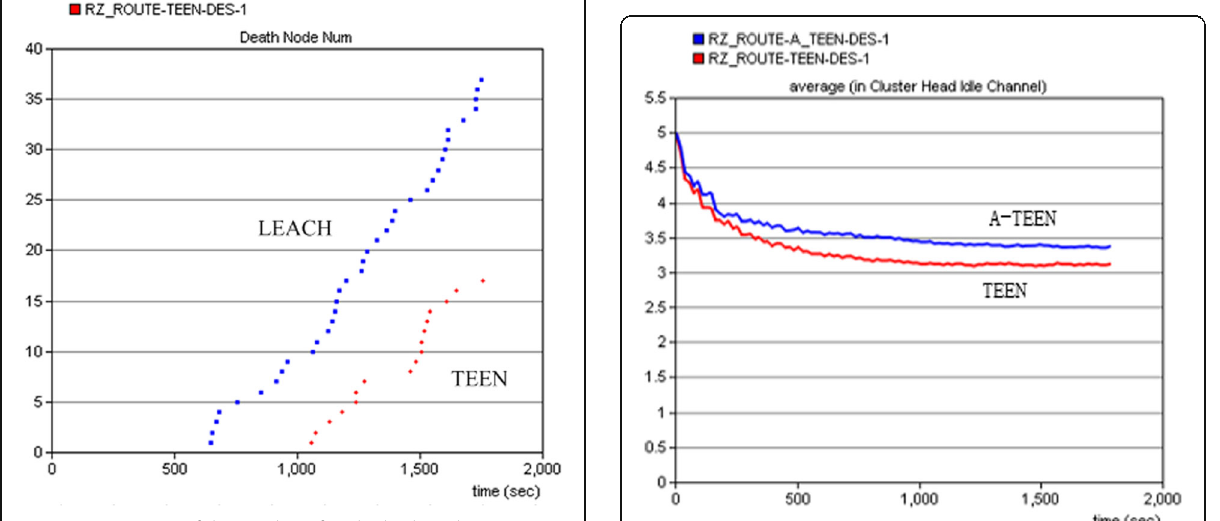
Fig. 10 Comparison of the number of node death under TEEN and LEACH Fig. 12 Comparison of available free channels